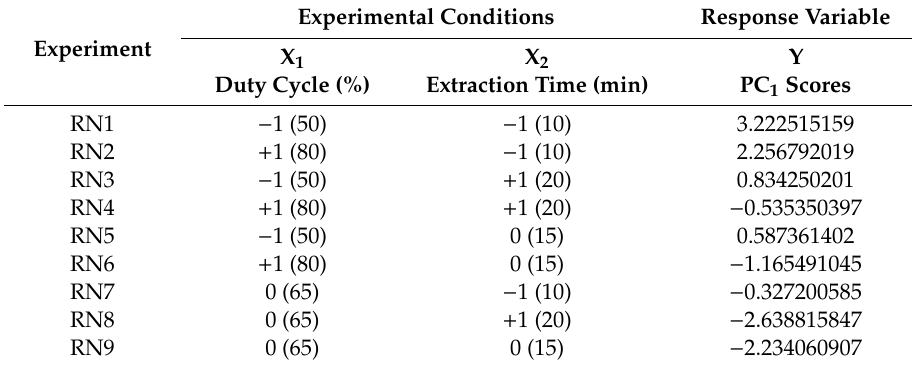
Table 1. Experimental matrix of the Faced Central Composite Design, the experimental plan (in brackets), and the obtained response variable